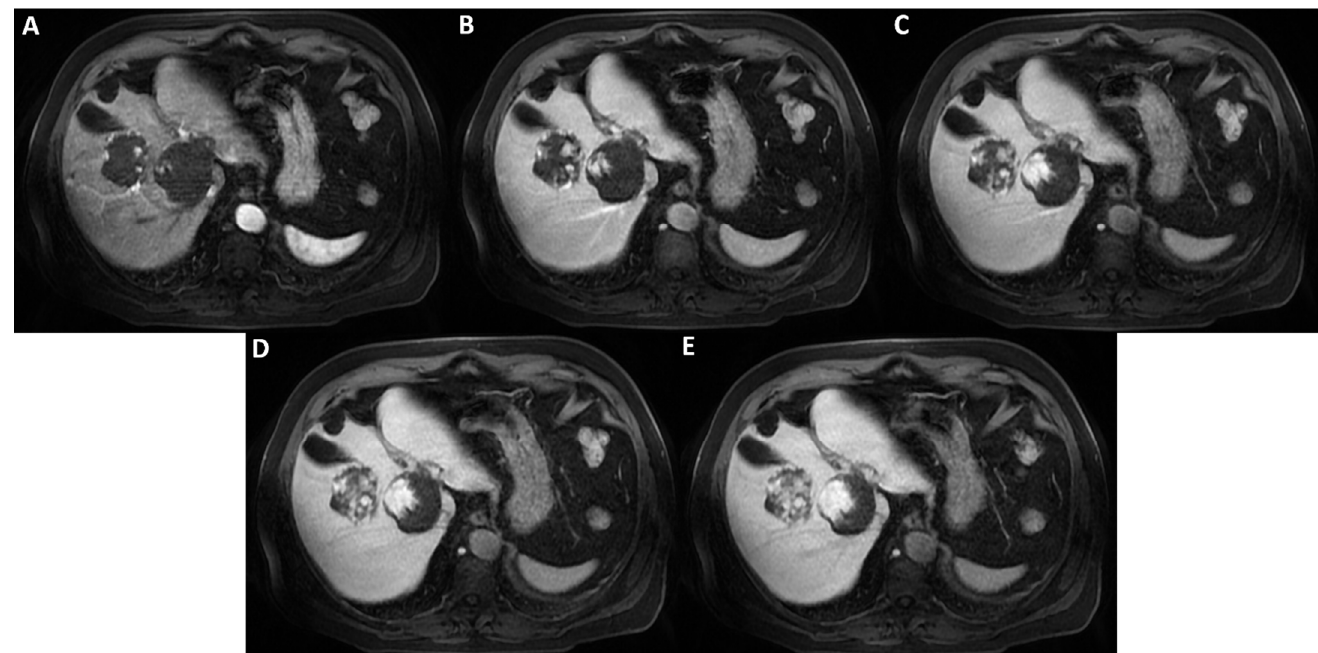
Figure 4. Axial T1-weighted fat saturated images after hepatospecific contrast agent (Gd-EOB- DTPA) administration in arterial, portal-venous, and delayed phases ( A – E ) show early peripheral discontinuous globular enhancement of the lesions with progressive centripetal filling-in on delayed scans. This angiodynamic behavior supports the diagnosis of cavernous